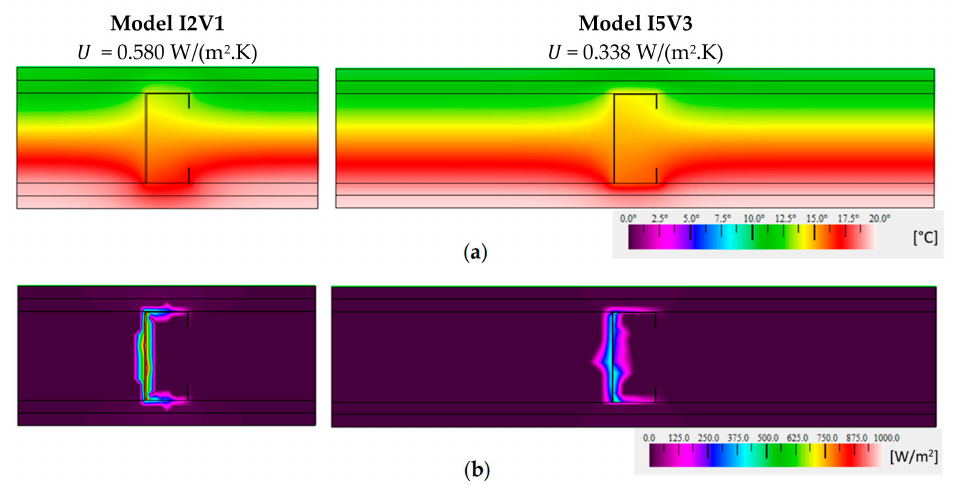
Figure 8. Temperature ( a ) and heat flux ( b ) color distribution for internal LSF wall models with the highest U -value increase (300 mm vertical stud distance) and decrease (XPS + GPB sheathing panels).